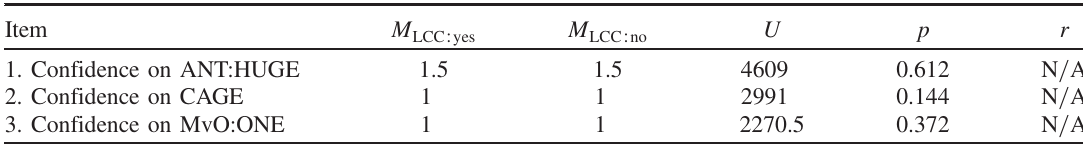
TABLE VII. Results of the two-group Mann-Whitney U test and median values for each group of students who exhibited a level confusion on a given prompt.